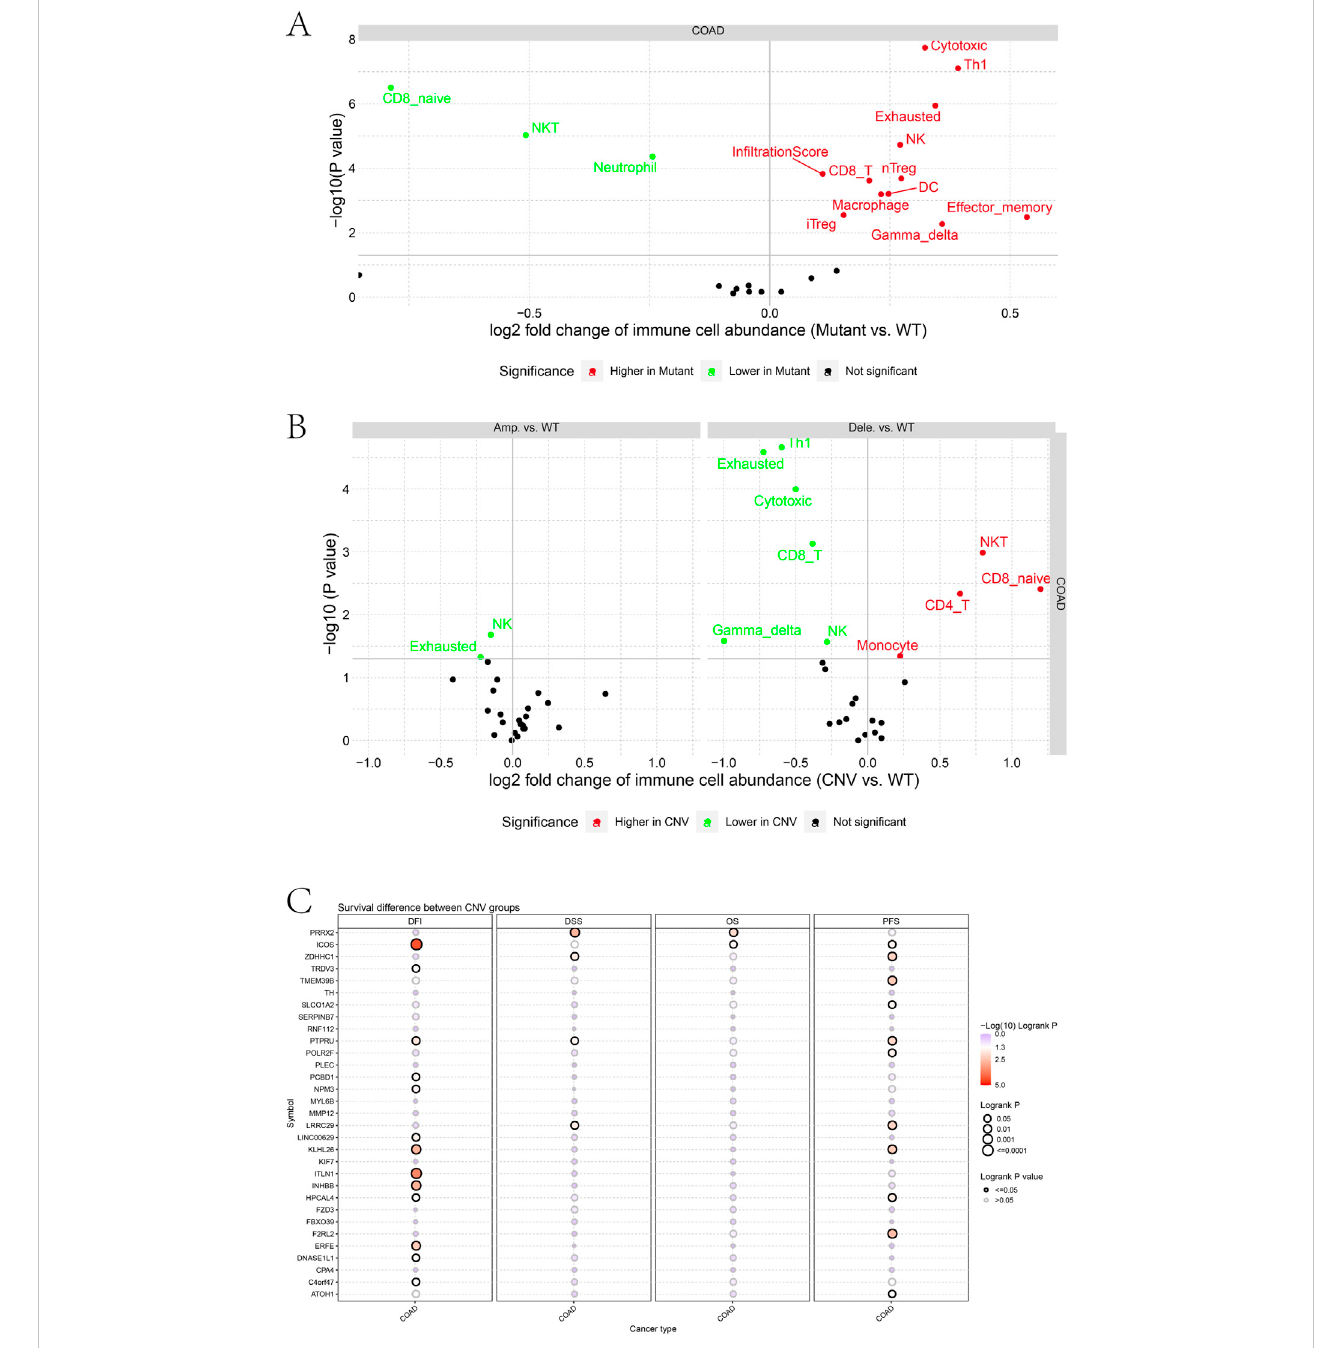
FIGURE 6 (A) Differencesinimmune cellabundancebetweenmutantandWTgroups. (B) DifferencesinimmunecellabundancebetweenCNVandWTgroups. (C) Survival difference between CNV